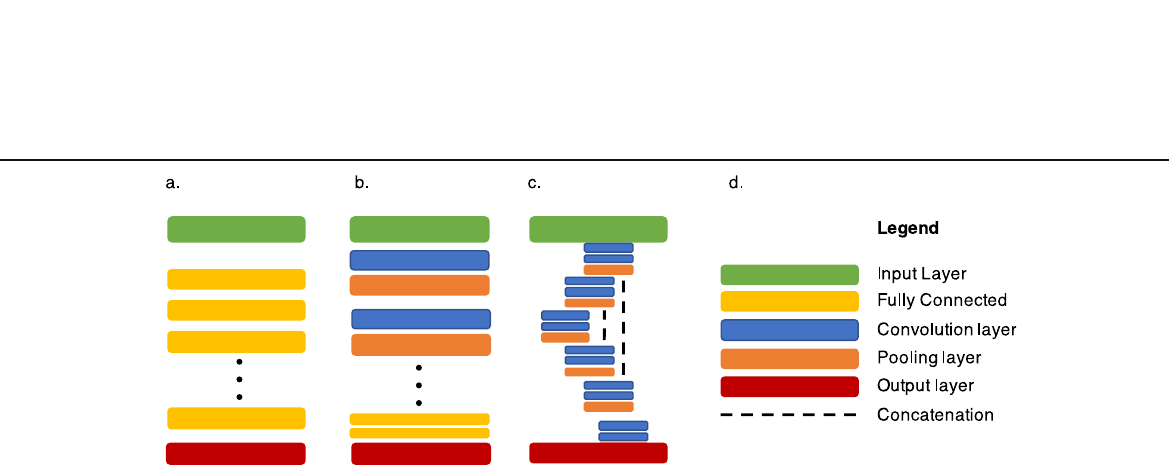
Fig. 8 Commonly used deep learning architectures. a Fully connected neural networks. b Convolutional neural networks for detection or classification. c U-net, for segmentation. d Legend illustrating the building blocks in various deep learning